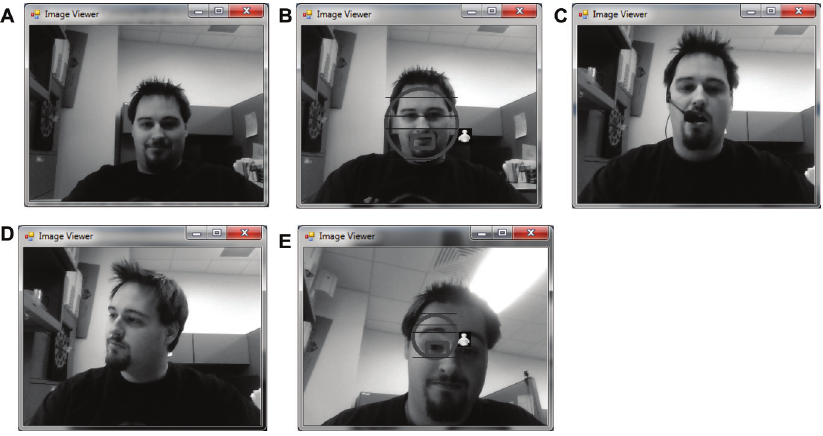
Figure 27. Image of Human Interlocutor for Interruption